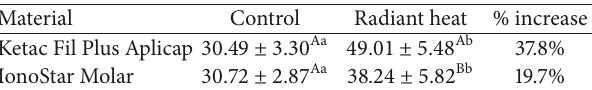
Table 2: Mean values and standard deviations of surface hardness (VHN) of the experimental groups of the study 24 h after prepara- tion of the specimens. The same uppercase superscripts in columns indicate no significant differences between materials ( 𝑝 > 0.05 ). The same lowercase superscripts indicate no significant differences between treatments ( 𝑝 > 0.05